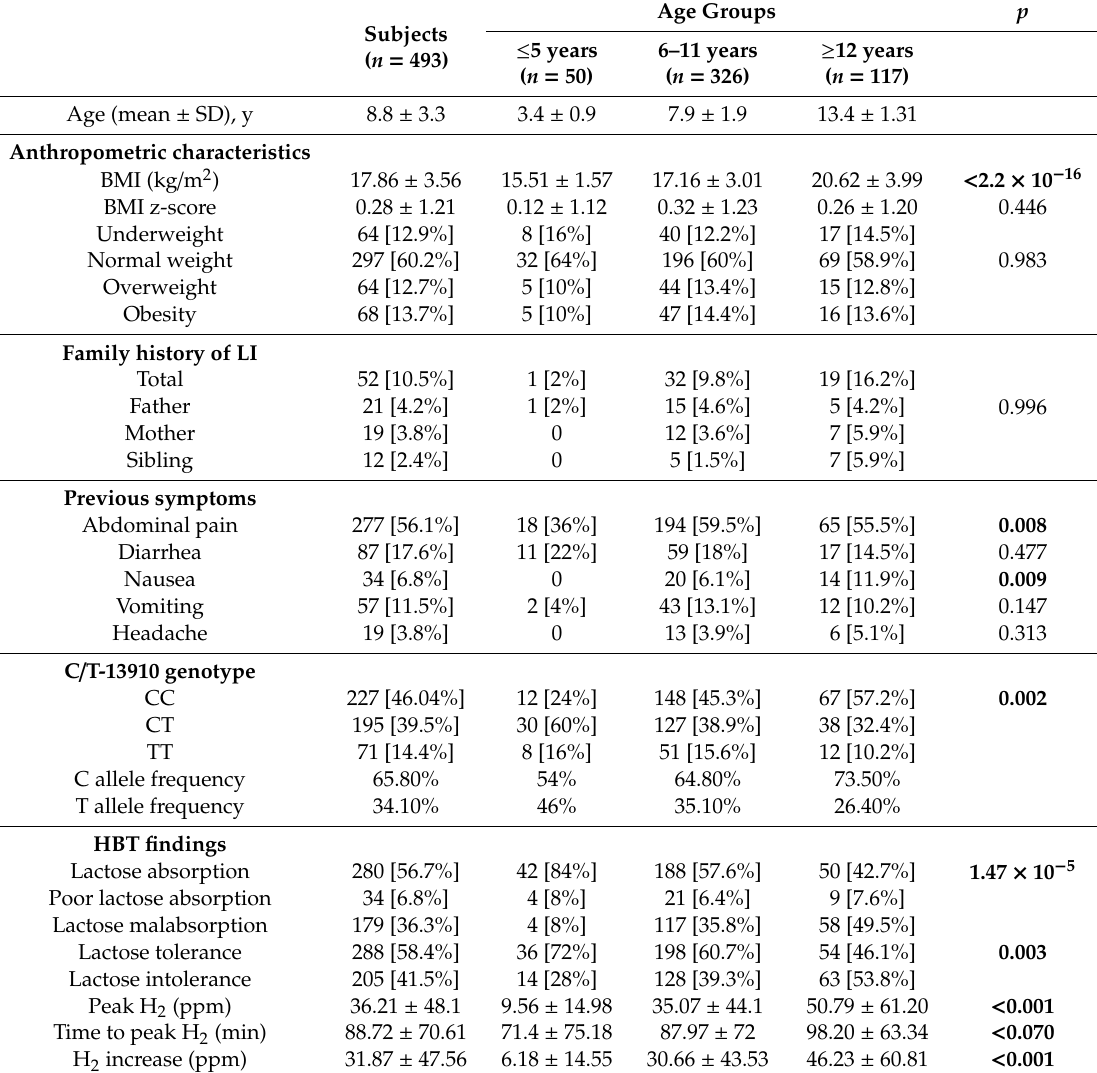
Table 1. Characteristics of the study